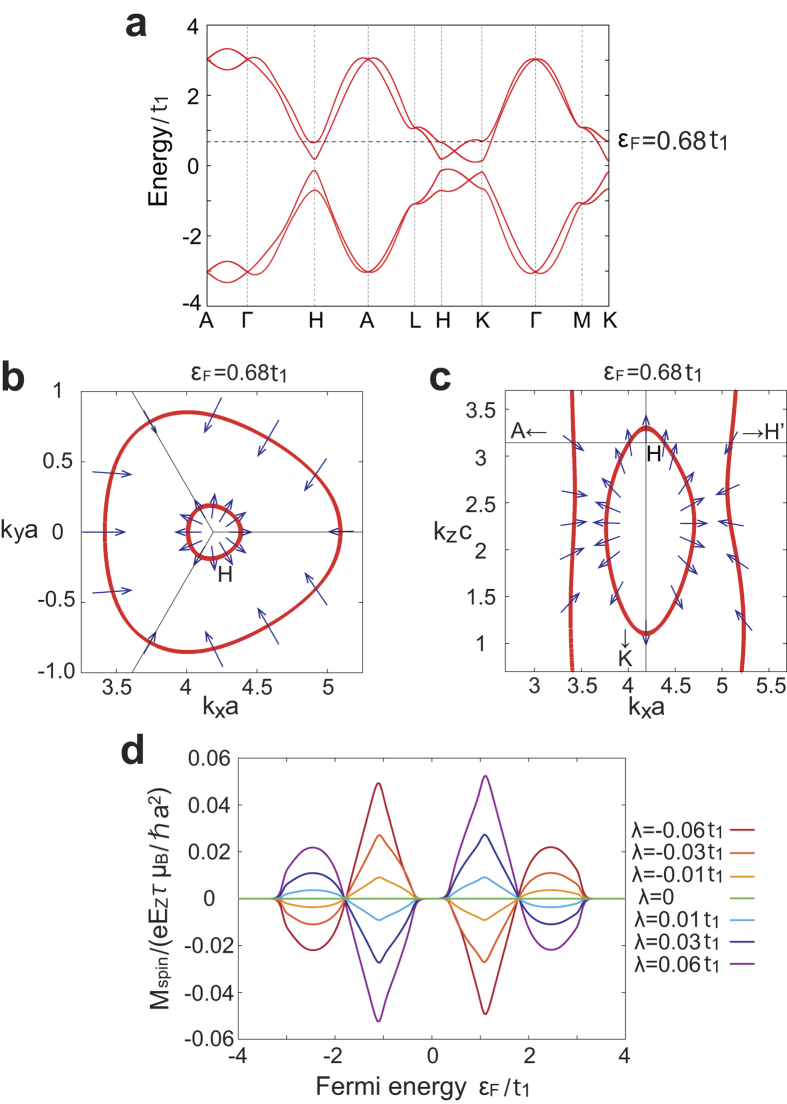
Current-induced spin magnetization.a Energy band for the Hamiltonian with λ = −0.06t1, λxy = λz = 0.05t1, and Δ = 0.4t1. Dashed line indicates εF = 0.68t1. b,c Fermi surface and spin texture. The parameters are the same as a. Arrows represent the spin projected onto each plane. The spin on the inner Fermi surface in b is drawn with three times larger scale. d Spin magnetization for several values of λ. The parameters are λxy = 0.05t1, λz = 0.05t1, and Δ = 0.4t1. We also set the temperature T = 0.03t1/kB.